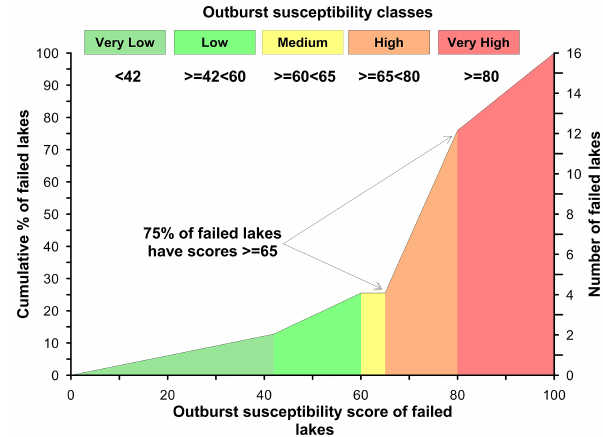
Figure 6. Outburst susceptibility score of the 16 moraine-dammed lakes failed in Patagonia. These data were used to define five out- burst susceptibility